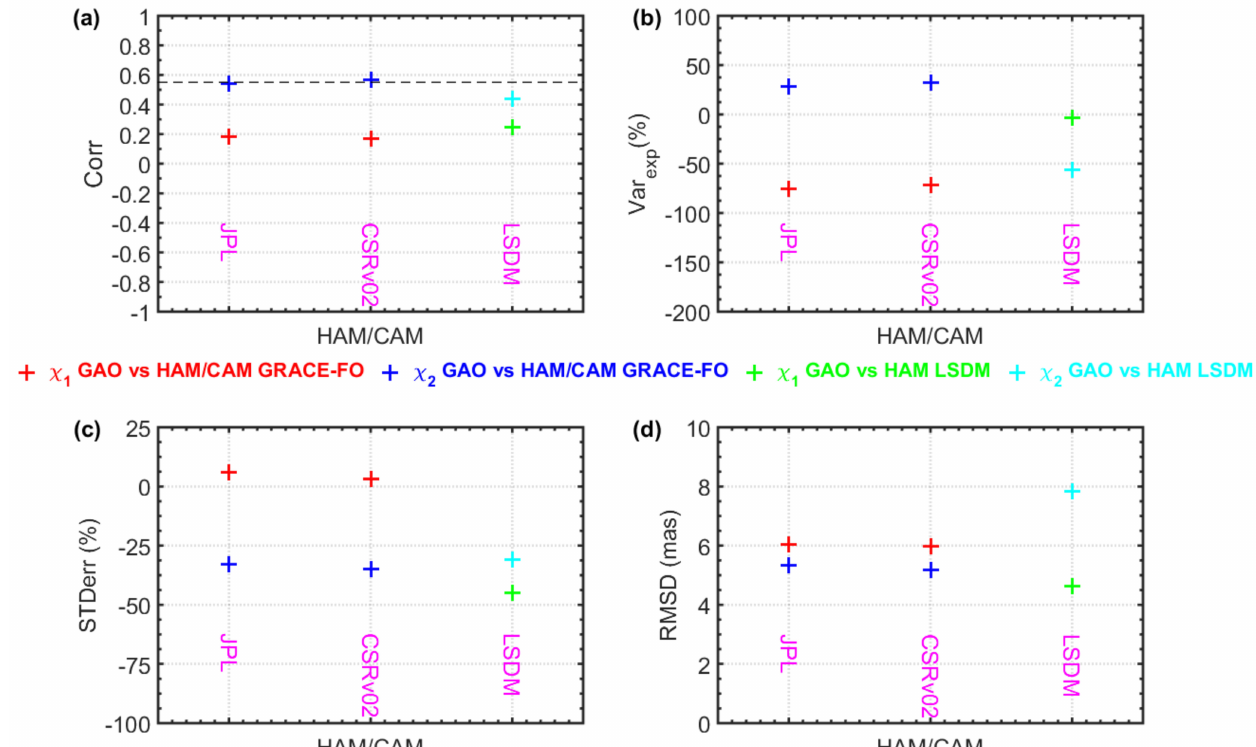
Figure 10. ( a ) Correlation coefficients (Corr) between HAM/CAM and GAO and between HAM and GAO, ( b ) percentage of variance in GAO explained by HAM/CAM and HAM (Var exp ), ( c ) error of STD (STDerr) of HAM/CAM and HAM, ( d ) root mean square deviation (RMSD) of HAM/CAM and HAM. Overall detrended time series are considered. Note that the critical value of the correlation coefficient for 10 independent points and a 95% confidence level is 0.55, while the standard error of the difference between the two correlation coefficients is